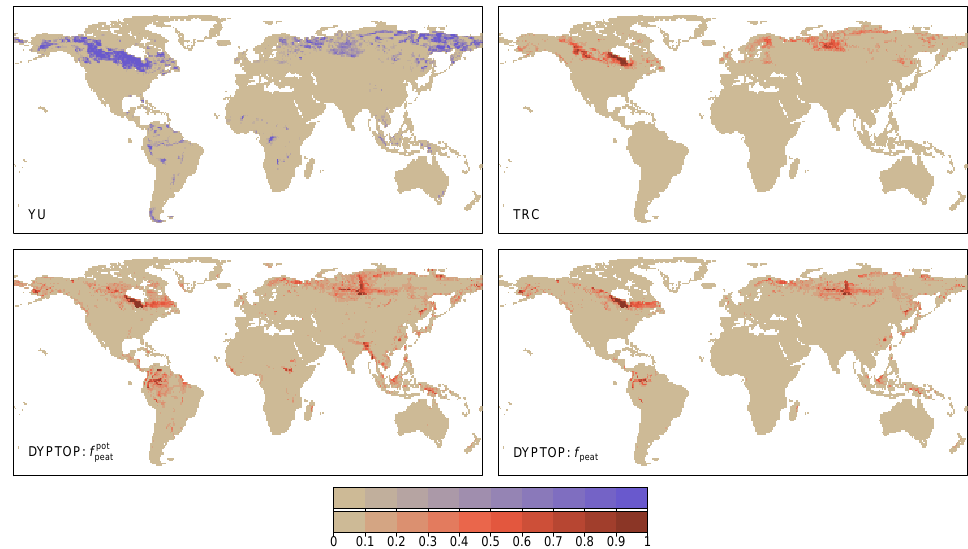
Figure 7. Observed and simulated peatland area fraction. Top row: observed, YU is based on Yu et al. (2010), TRC is based on Tarnocai et al. (2009). Original YU data delineate grid cells with a significant peatland cover fraction ( > 5%). Original binary data on 0.05 ◦ × 0.05 ◦ are regridded to represent the fractional area with significant peatland cover fraction on the 1 ◦ × 1 ◦ grid. This information is not directly comparable to other panels and is therefore illustrated with a distinct colour key. Bottom row: simulated, f pot peat is the potential, hydrologically suitable peatland area fraction after peatland establishment, f peat is the simulated actual peatland area fraction taking account of the carbon balance